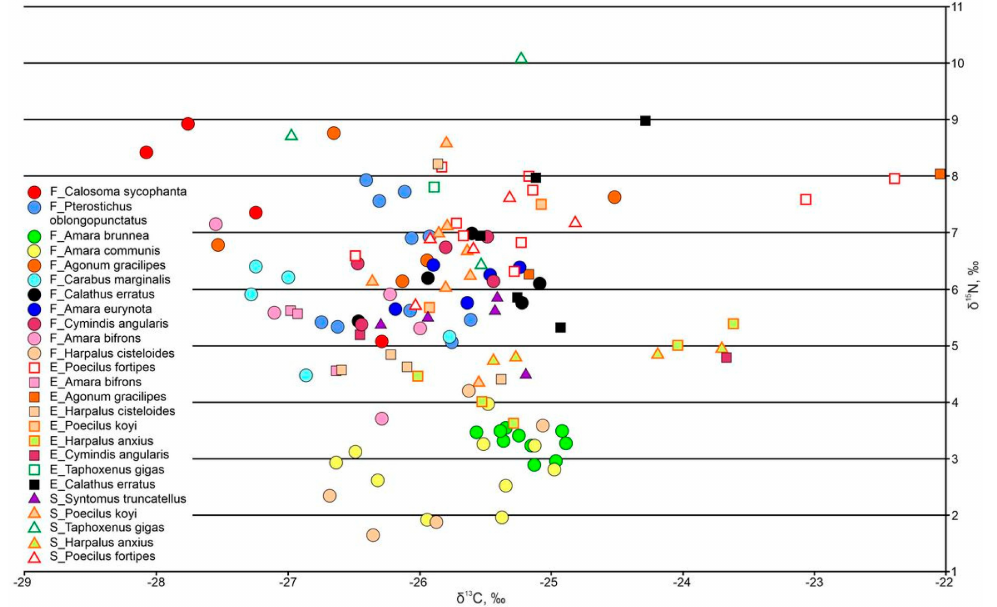
Figure A3. Distribution of carabid beetles of the studied ecosystems in the δ 13 C– δ 15 N isotopic biplot. Each symbol shows one specimen. F: forest (circles), E: edge (squares), S: steppe (triangles).